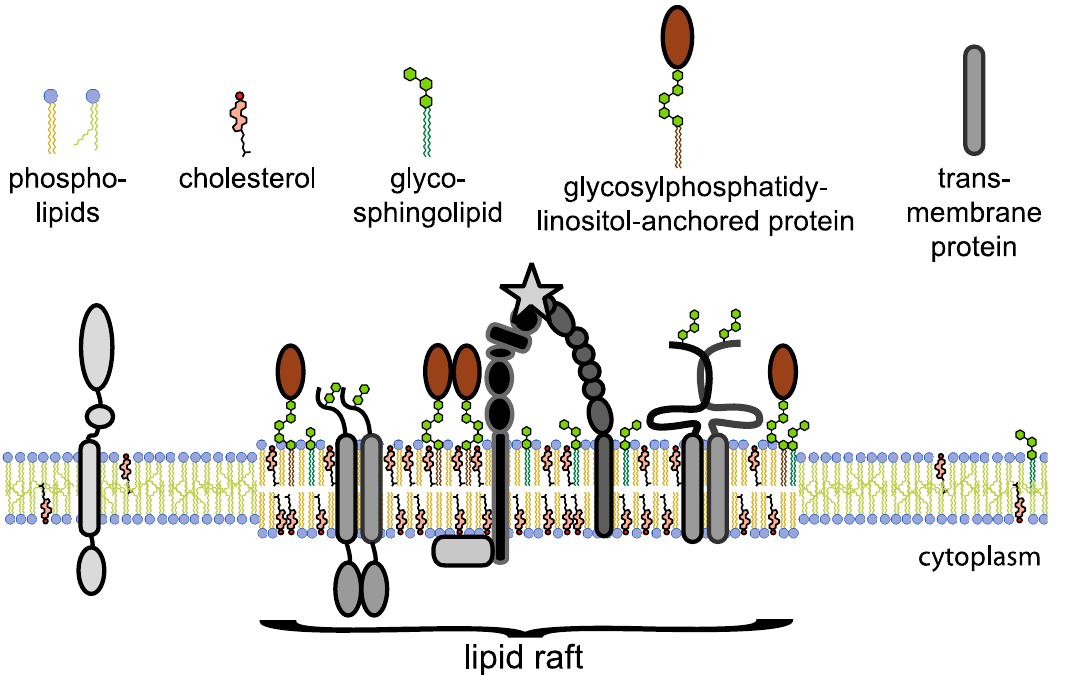
Figure 1. Schematic of lipid raft organization. The asymmetric plasma membrane contains phospholipids, glycosphingolipids, cholesterol, and protein receptors that are organized in the thicker lipid microdomains. These lipid rafts compartmentalize cellular processes and signal transduction by organizing and concentrating signaling molecules to more favorably interact with protein receptors as well as effectors. Lipid rafts float freely in the plasma membrane while being packed tighter and more ordered compared to non-raft regions.